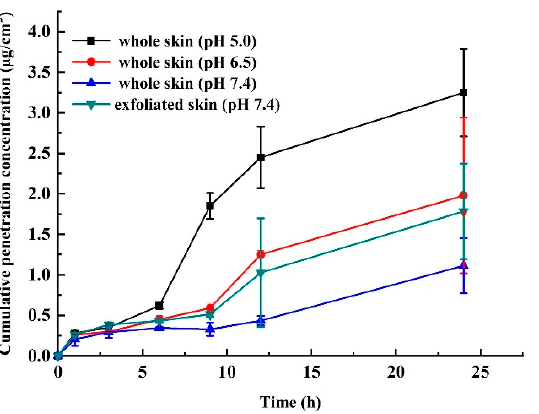
Figure 5. Percutaneous permeation dose-time curves of MTX in MTX-mSiO 2 @PDA measured under different pH conditions. Data are shown as mean ± SD (n = 3). different pH conditions. Data are shown as mean ± SD (n =